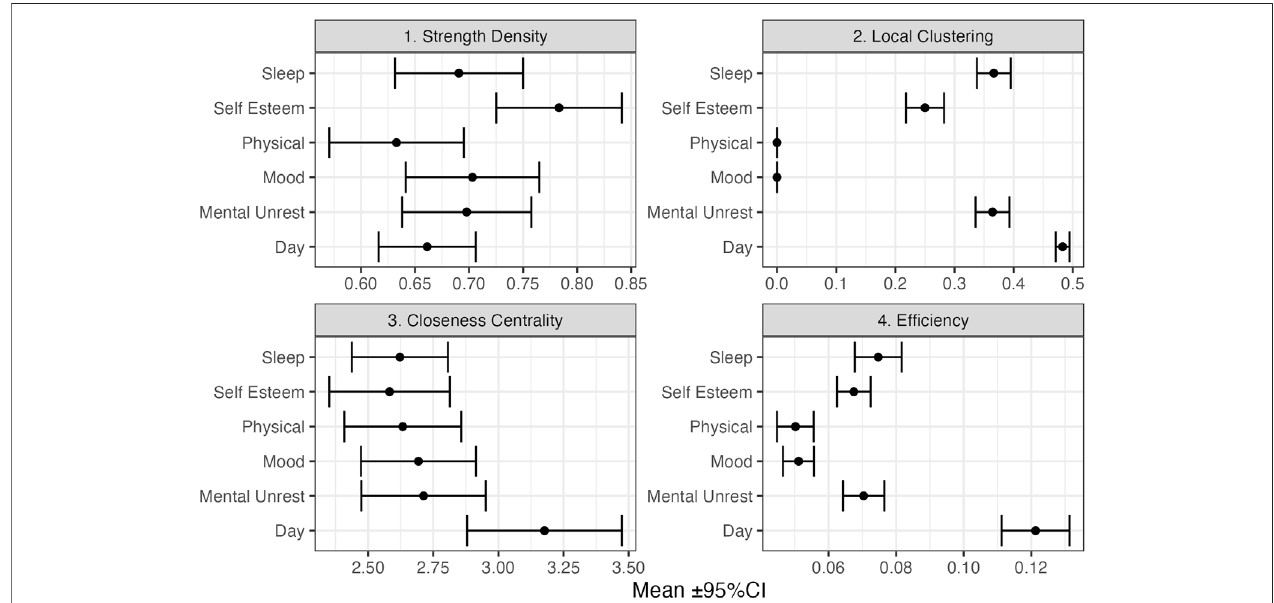
FIGURE 10 | Mean Local vertex characteristics over all 7-days windows ( N = 232) for each layer in the Multiplex cRN. The fi gure displays the results based on the MRN with inter-layer MI as edge weights.